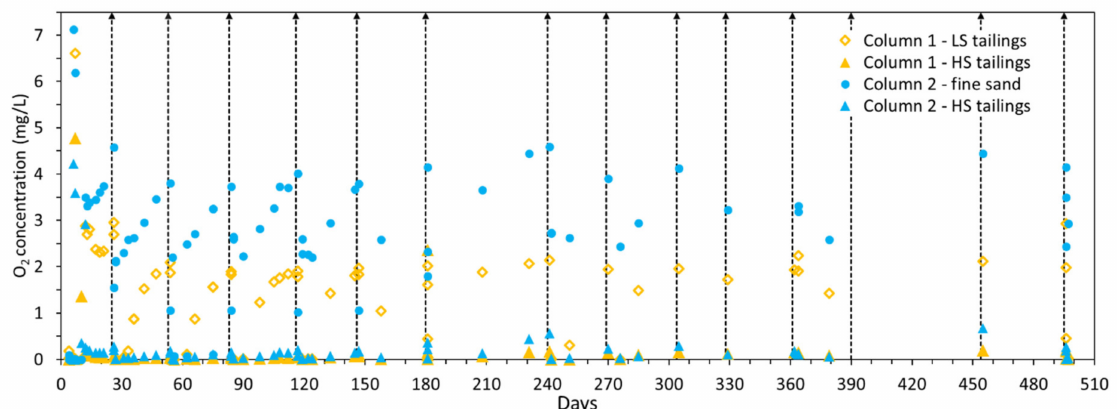
Figure 6. O 2 concentrations measured in columns 1 and 2 as a function of time. Vertical dashed lines mark the beginning of wetting-drying cycles. The location of oxygen sensors is indicated in Figure